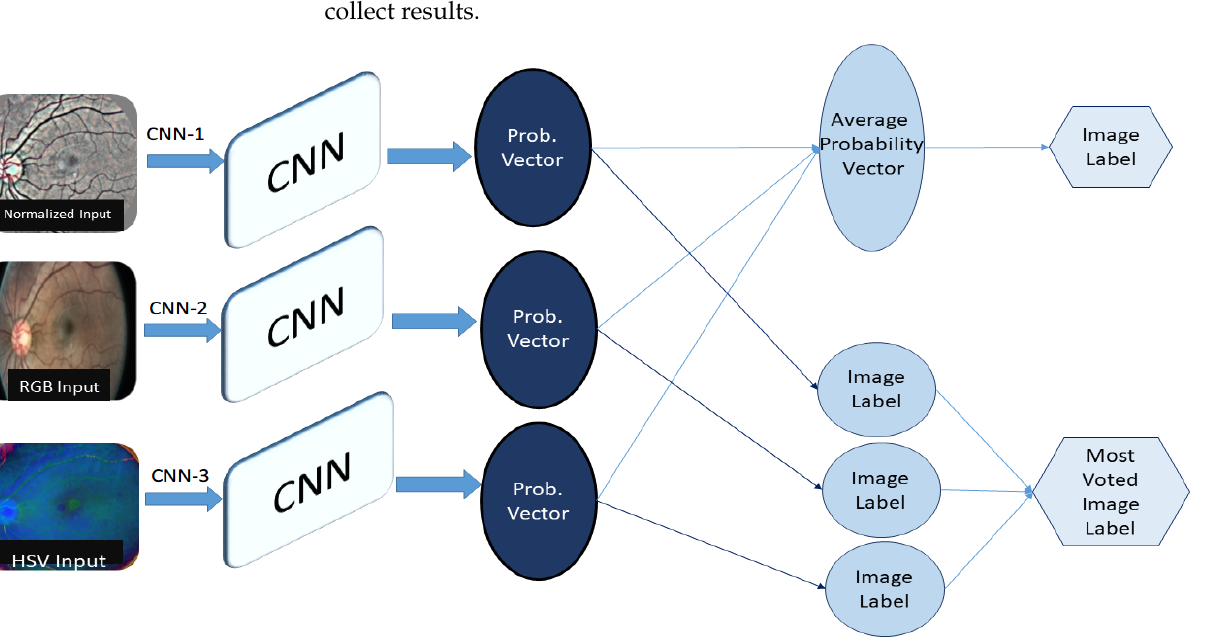
Figure 6. Framework 2-Ensembled System